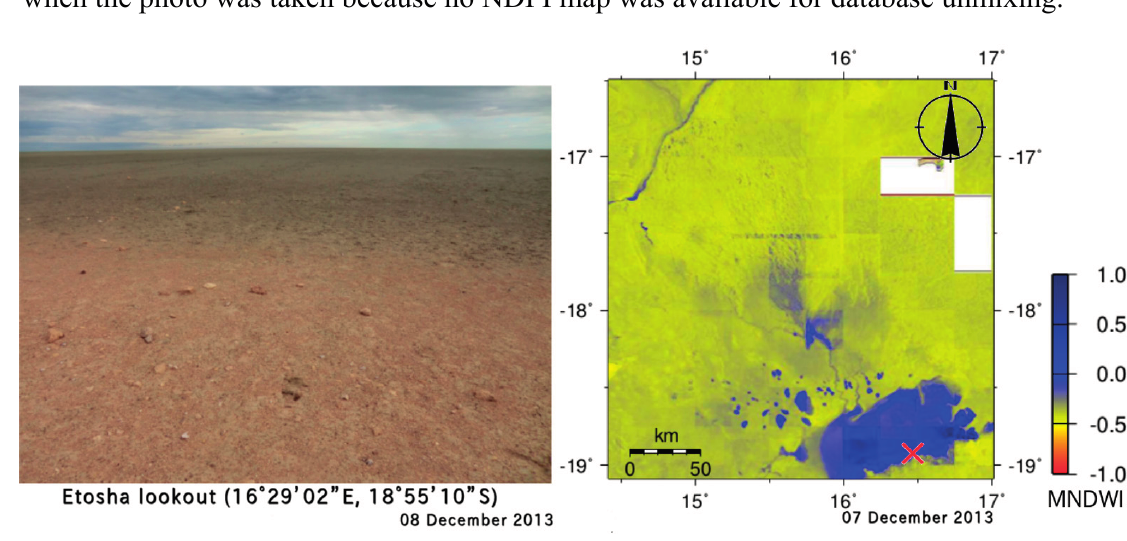
Figure 13. Photograph taken at the Etosha lookout (the red x) and the gap-filled MNDWI map for the closest day. We could not obtain a gap-filled MNDWI map for the same day when the photo was taken because no NDPI map was available for database